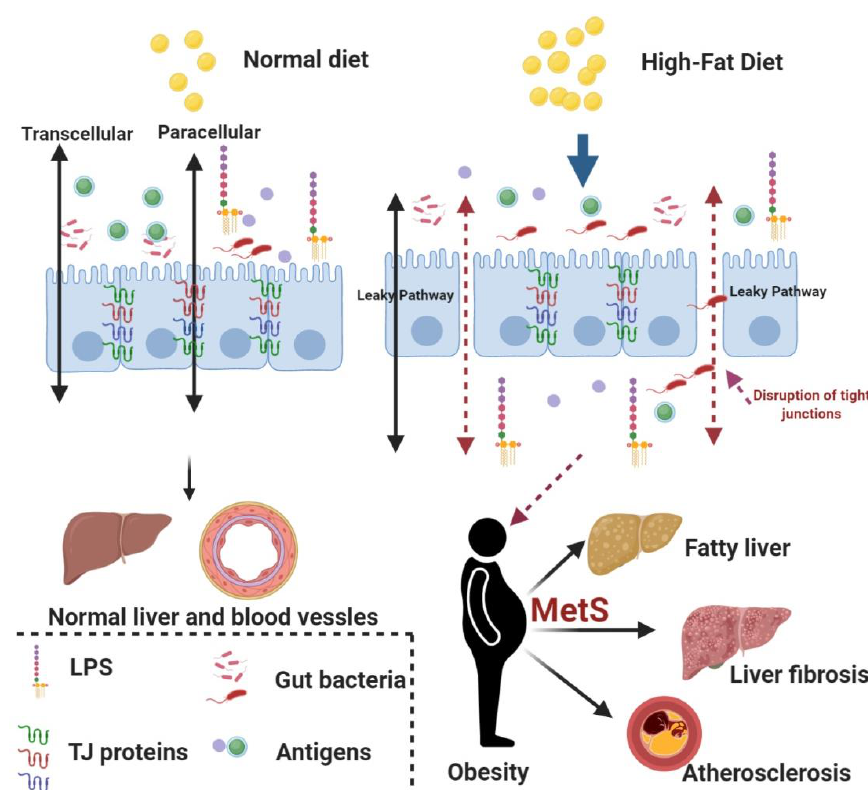
Figure 1. The association between a high-fat diet (HFD), obesity, and obesity-associated complications. High-fat diet promotes the disruption of tight junctions by reducing the expression of key tight junction proteins such as Zonula Occludens-1 (ZO-1), Claudin-1 and Occludin. This compromised intestinal barrier leads to uninterrupted entry of gut bacteria and several bacterial-derived antigens (i.e., lipopolysaccharides (LPS)) to the systemic circulation and promotes a chronic low-grade systemic inflammation in the body. The chronic low-grade inflammation has been considered as a major cause for obesity and other associated complications, such as fatty liver, liver fibrosis, and atherosclerosis (MetS: Metabolic Syndrome).